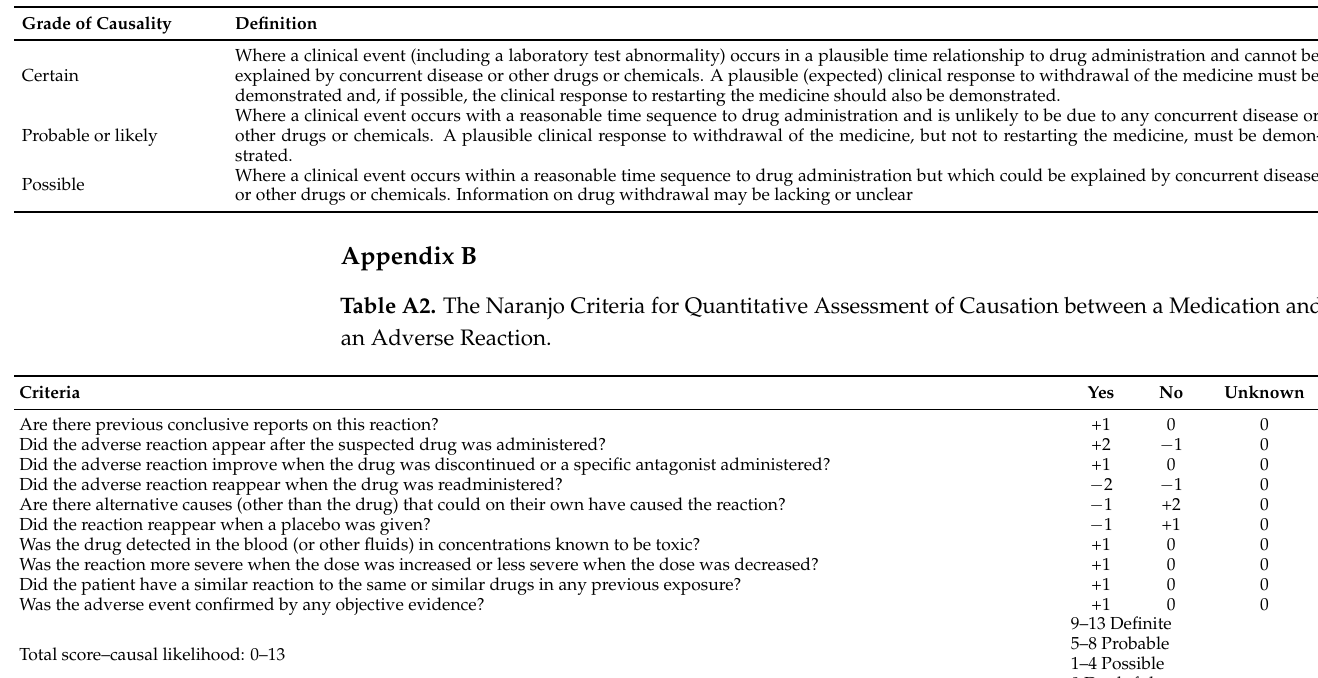
Table A1. Causality Assessment of Suspected Adverse Drug Reactions (World Health Organization).